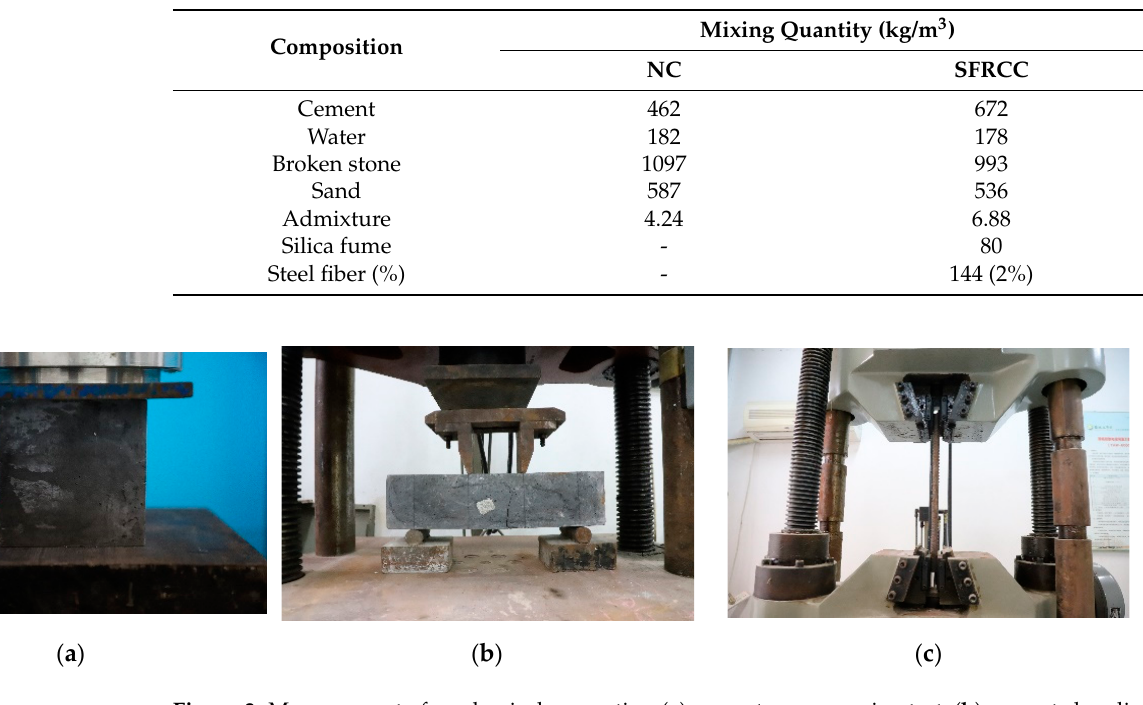
Table 1. The mixing ratio of concrete.